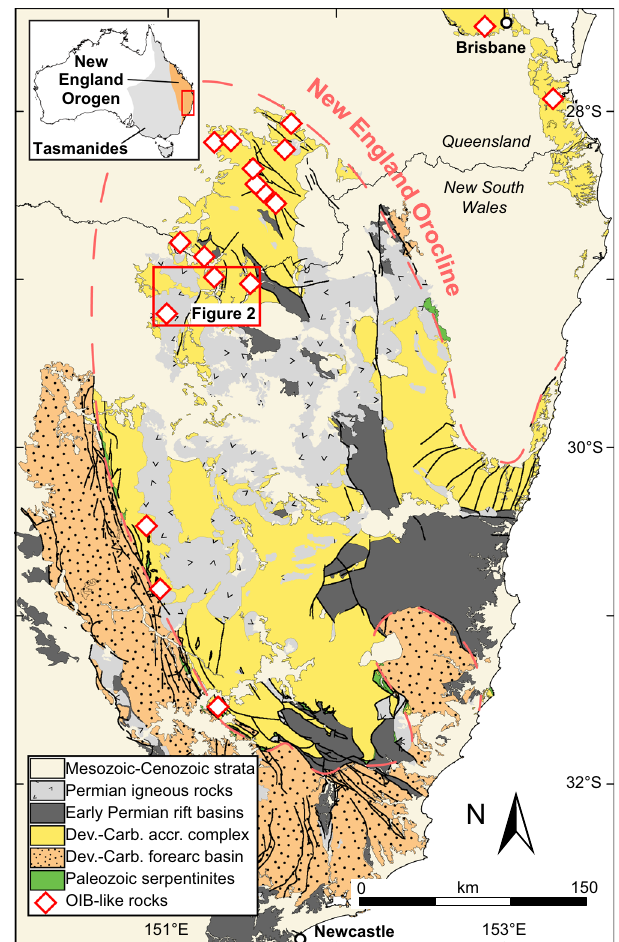
Fig. 1 Geological map of the southern New England Orogen (modi fi ed from ref. 49 ). OIB-like rocks from refs. 34,35 . Accr. Accretionary, Dev.-Carb. Devonian-Carboniferous, OIB Ocean island